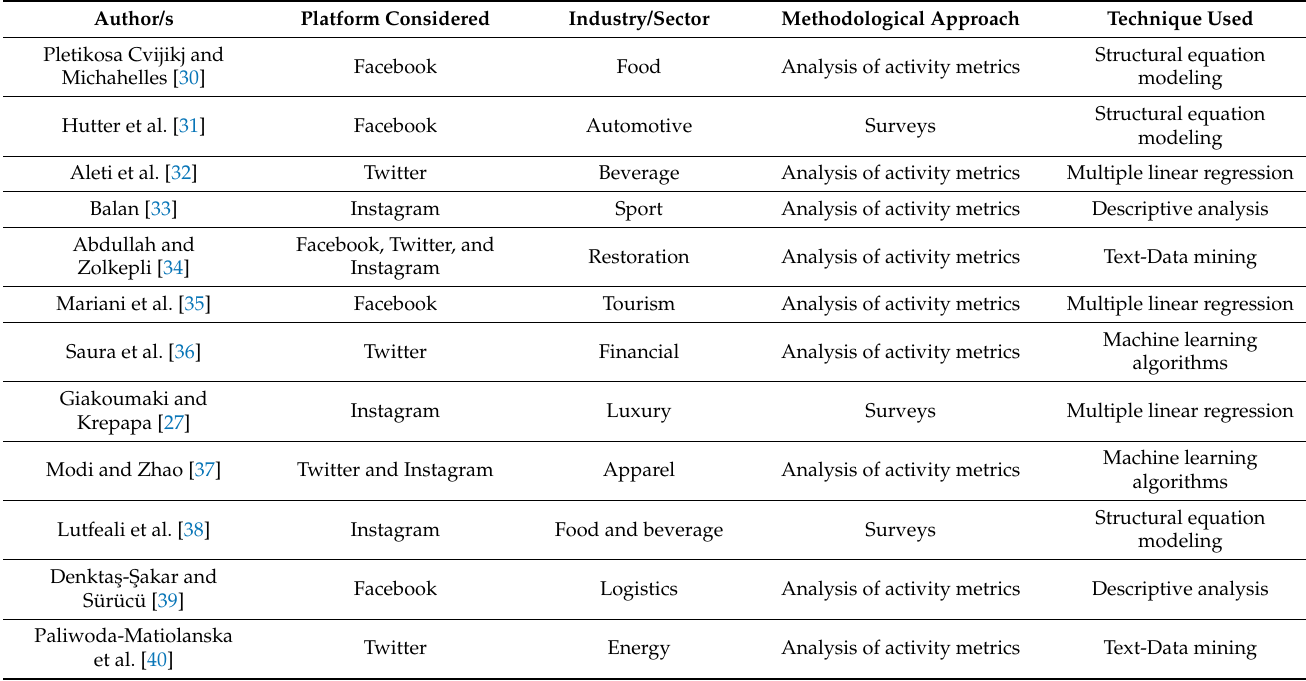
Table 1. Studies on customer engagement in social